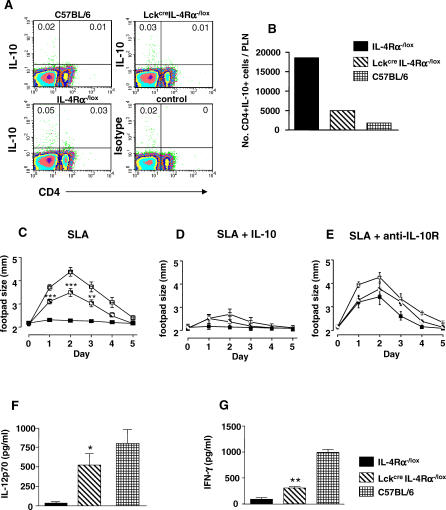
IL-10 Inhibits Protective Responses(A and B) Increased numbers of IL-10–secreting cells in IL-4Rα−/lox mice. (A) CD4+ IL-10–secreting cells were identified by intracellular FACS in LN cells restimulated with SLA for 24 h in vitro from L. major–infected mice 6 wk after infection. Data represent one of two independent experiments (pool of eight popliteal LNs/group). (B) Total numbers of CD4+ IL-10–secreting cells per draining LN.(C–E) Susceptible mice exhibit poor DTH responses controlled by IL-10. At 6–8 wk after infection with L. major, mice (five mice per group) were injected in the contralateral hind footpad with (C) 10 μg SLA subcutaneously, (D) 10 μg SLA and 0.5 μg IL-10 subcutaneously, and (E) 10 μg SLA and 1.5 μg anti–IL-10R subcutaneously. Footpad swelling was monitored every 24 h for 5 d. (***p < 0.001, **p < 0.01 LckcreIL-4Rα−/lox versus WT). The data represent one of two independent experiments.(F) Increased IL-12p70 in DTH footpads of resistant mice. Lysates of footpads (four per group) taken 24 h after induction of DTH responses were analyzed for IL-12p70. The data represent the pool of two independent experiments (*p < 0.05, LckcreIL-4Rα−/lox versus WT).(G) Increased IFN-γ in DTH footpads of resistant mice. Lysates of footpads (four per group) taken 24 h after induction of DTH responses were analyzed for IFN-γ. The data represent the pool of two independent experiments (**p < 0.01, LckcreIL-4Rα−/lox versus WT).